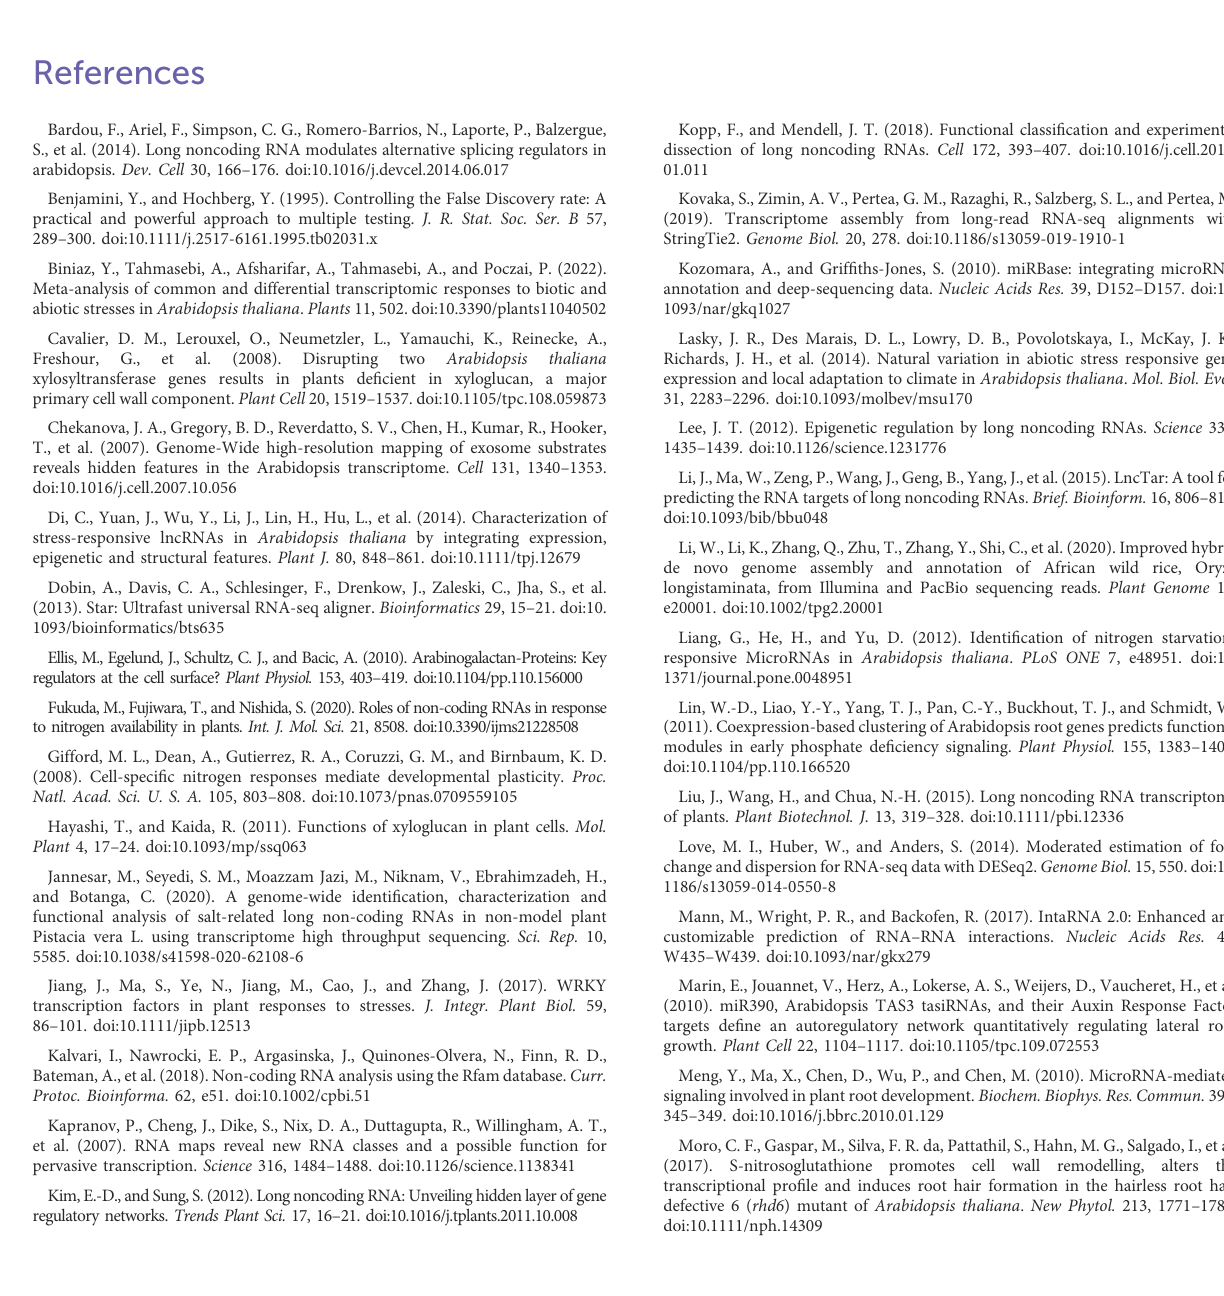
and IAA-treated seedlings. The edge sheets show gene pairs correlation (positive values) or anticorrelation (negative values). The node sheets show DElncRNA (bait node) and DE PCG (family node) identi fi cation. Additionally, the list of exclusive DE PCG identi fi ed for GSNO and IAA treatments are provided along with their biological role. Details from 1) DElncRNA and DEmRNA, 2) DEsRNA and DElncRNA, and 3) DEsRNA and DEmRNA interactions analysis performed. Stronger interactions are represented by smaller negative values (kcal/mol).